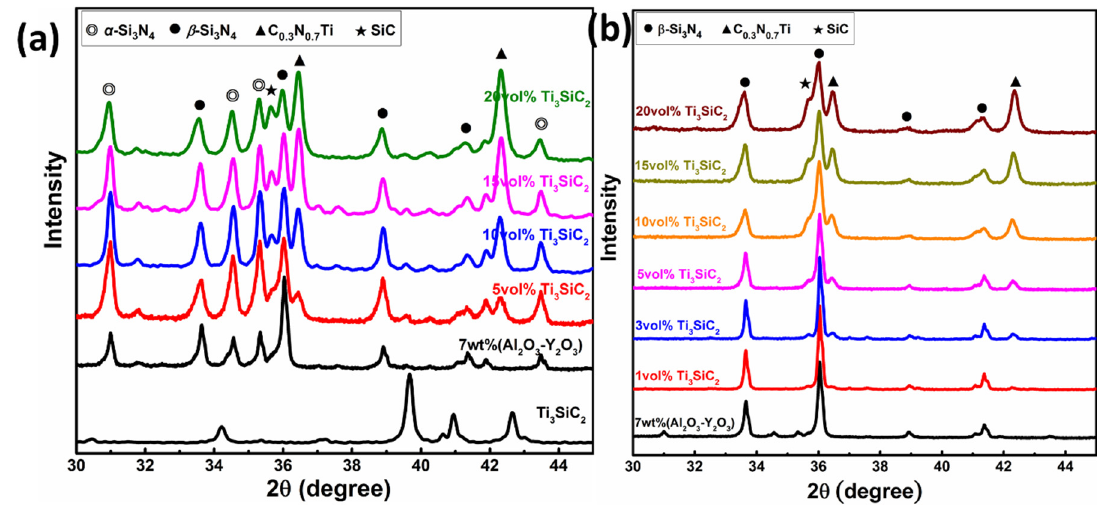
Figure 1. Density of Si 3 N 4 ceramics as a function of Ti 3 SiC 2 content. As expected, higher sintering temperature 1700 °C could further promote densification of Si 3 N 4 ceramics filled with Ti 3 SiC 2 . Besides, experimental points are inclined to distribute on a straight line with coefficient of determination ( R 2 ) above 0.99. To investigate the composition evolution after sintering, XRD patterns of Si 3 N 4 ceramics filled with different volume fraction of Ti 3 SiC 2 sintered at 1600 and 1700 °C, as well as 7 wt.% (Al 2 O 3 -Y 2 O 3 ) densified Si 3 N 4 ceramics are shown in Figure 2. As